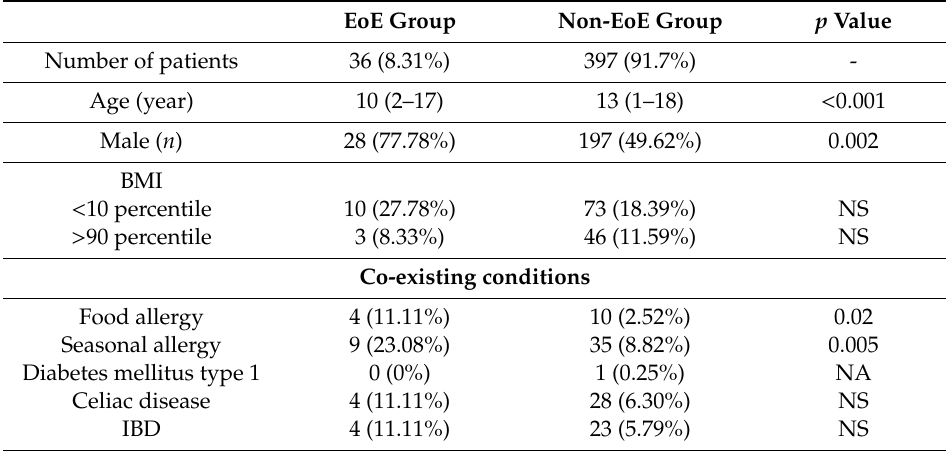
Figure 1. New eosinophilic esophagitis (EoE) cases per 100,000 children in the North-Eastern Poland. Table 1. Demographic data and clinical manifestation in eosinophilic esophagitis (EoE) and non-EoE groups.